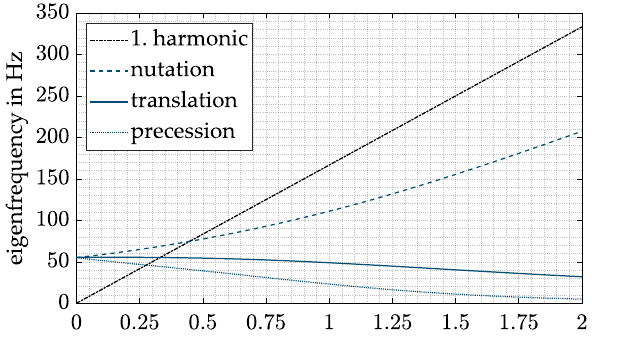
Figure 7. ( a ) Campbell diagram with DFC; ( b ) decay rate with DFC.